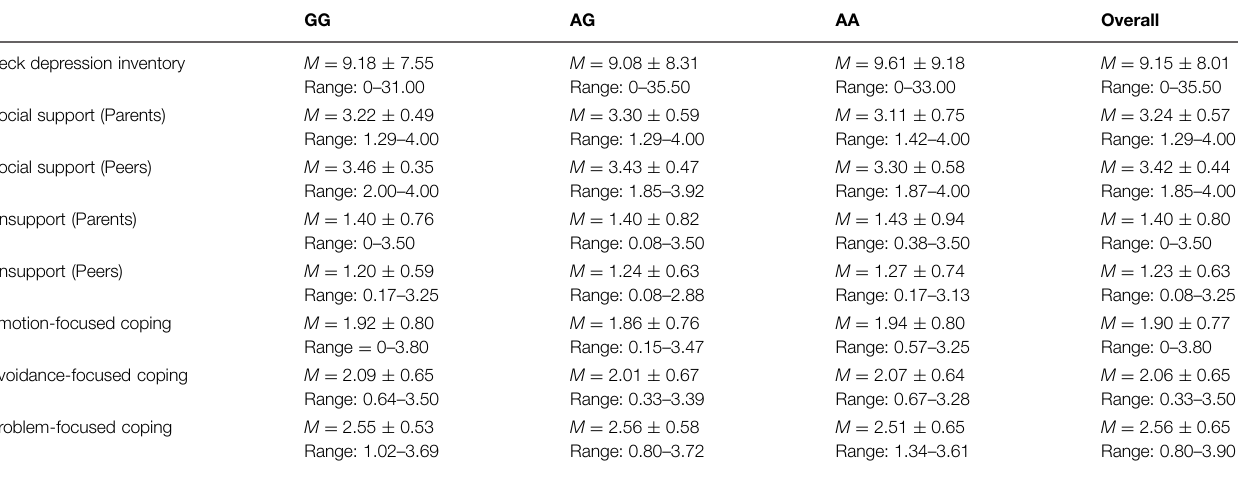
TABLE 1 | Mean, SD, and range for study variables by oxytocin receptor gene (OXTR) rs53576 genotype.